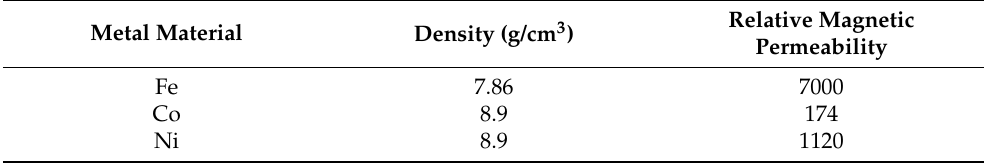
Table 2. Properties of wear debris.